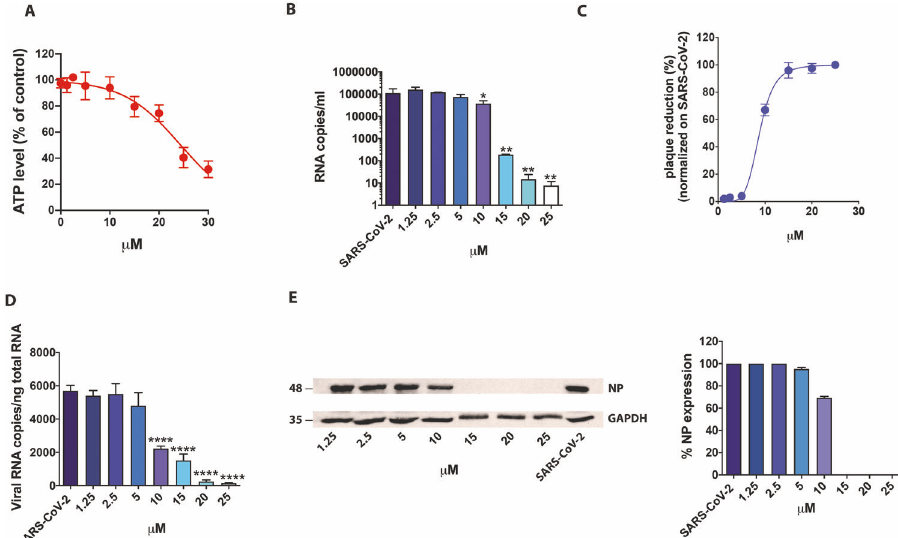
Fig. 2 Effect of raloxifene on Calu-3 cells. Calu-3 cells were cultured for 48 h in absence or in the presence of raloxifene at different concentrations. A CellTiter-Glo was used to measure the antimetabolic effect of raloxifene. B – E Cells were infected with SARS-CoV-2 and cultured in the absence or in the presence of different doses of raloxifene. B Viral yield in cell supernatants was quantitated by qRT-PCR. C Viral titer in cell supernatants was evaluated by plaque assay and plotted as percentage of plaque reduction compared to SARS-CoV-2. D Quantitation of SARS-CoV-2 genomes at the intracellular level by qRT-PCR. E Nucleocapsid (NP) protein expression in infected cells was analyzed by western blot (left panel). Densitometric analyses of western blot results are shown. Graph represents the percentage of NP protein expression. All the experiments were performed at least in three independent replicates and pictures shown are representative. Data are presented as the mean + standard error of the mean * P < 0.05; ** P < 0.01; **** P <